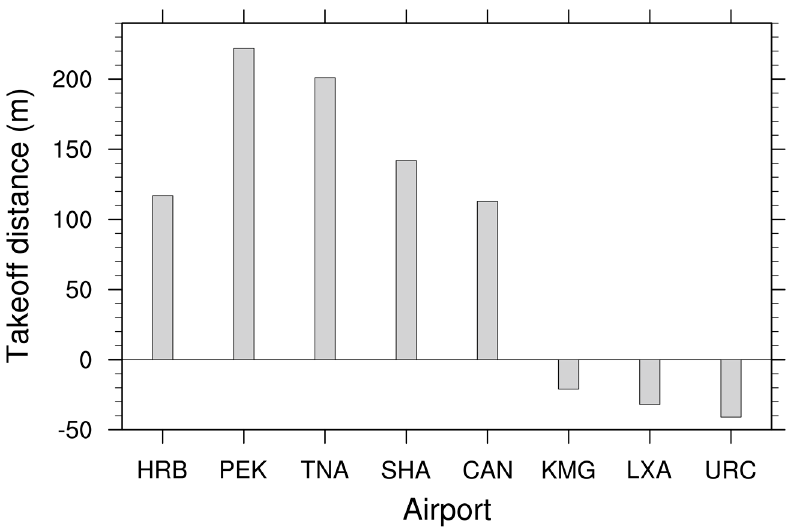
Figure 6. Takeoff distance changes (m) during the period 2071 − 2080 relative to 1991 − 2000.